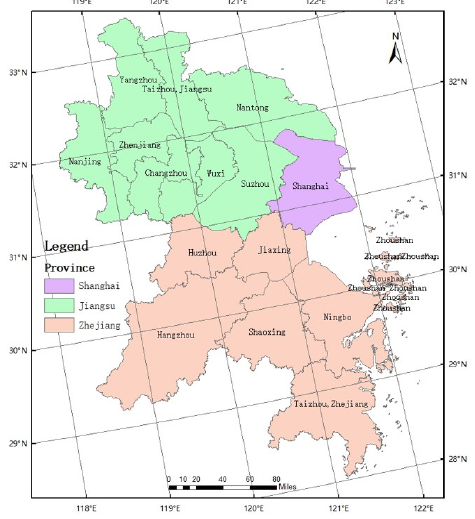
Figure 1 . Location map of Yangtze River Delta urban agglomeration.